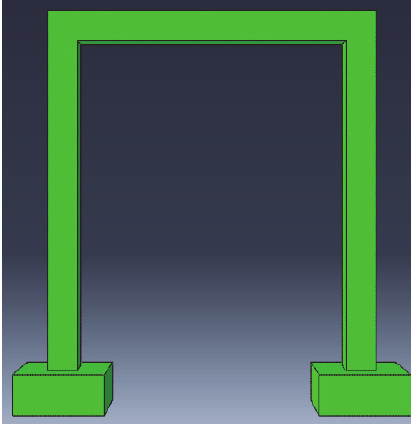
Figure 2: Typical timber frame models